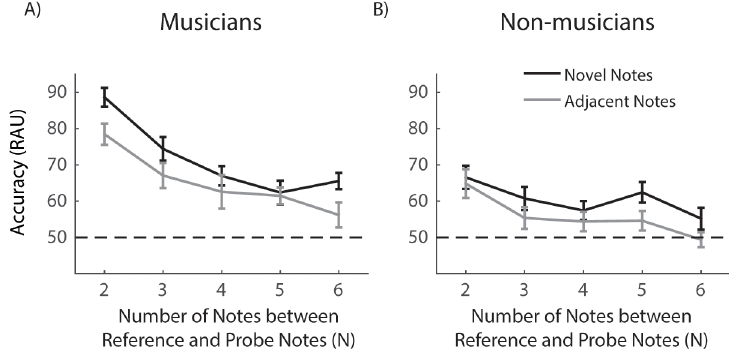
Fig 5. Comparison between the novel and adjacent notes in the N-back tonal task. Performance of musicians ( A ) and non-musicians ( B ) as a function of the notes between the reference and probe notes (N) when the probe note was a novel note (black curve) or identical to a note adjacent to the reference note (grey curve). The performance is plotted as the accuracy (RAU). Horizontal dash lines in all plots represent the chance level. Error bars are corrected S.E.M across